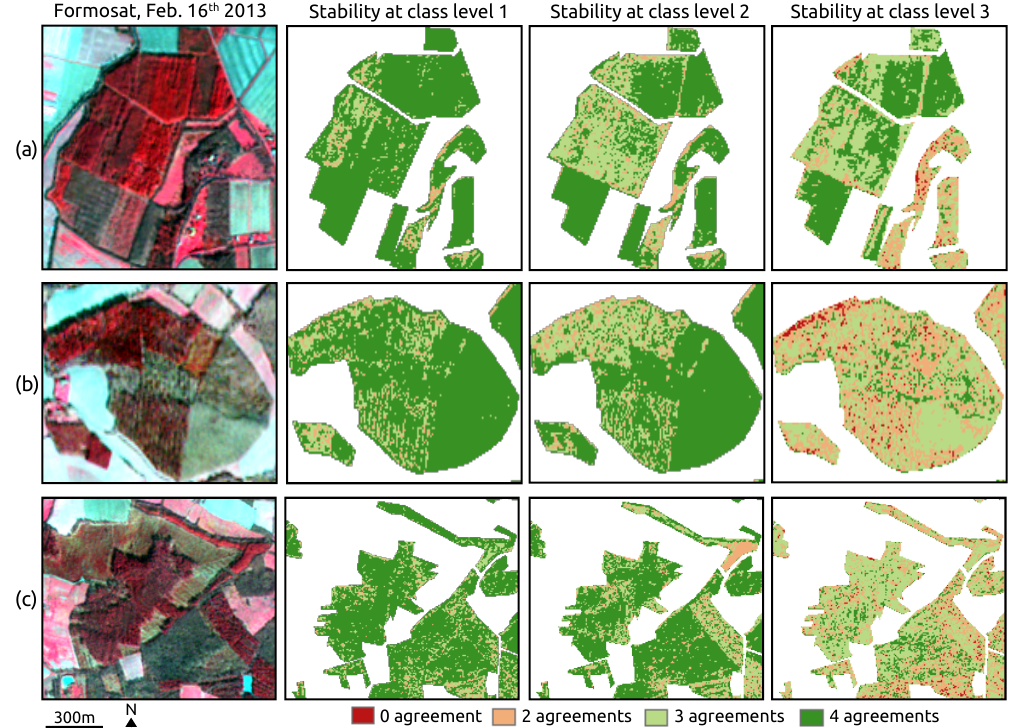
Figure 7. Degree of relative agreement between the SVM, RF, k-NN and GMM classifiers at the three classification levels using W bands dataset. Stability is observed at level 3 for monospecific tree plantations in ( a ) compared to complex forests with mixed pixels in ( b ) and ( c